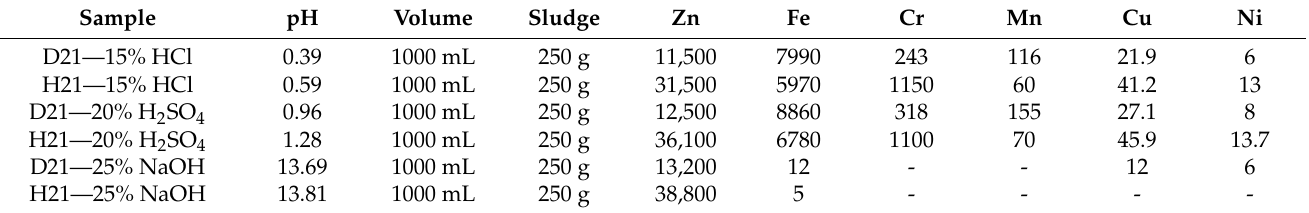
Table 13. The pH values and the results of AAS analyses of the leaches (mg/L) after leaching in HCl, H 2 SO 4 and NaOH.